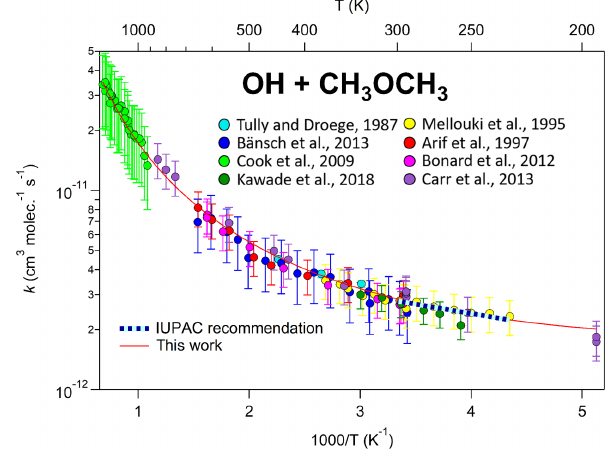
Figure 2. Temperature dependence of the reaction of OH with dimethyl ether. As with many other reactions, curvature in Arrhe- nius space is observed over sufficiently large temperature ranges, especially in systems where quantum tunnelling, pre-reactive com- plexes, and multiple reaction channels are active. This highlights the need to use the modified Arrhenius expression for some of the reactions in this